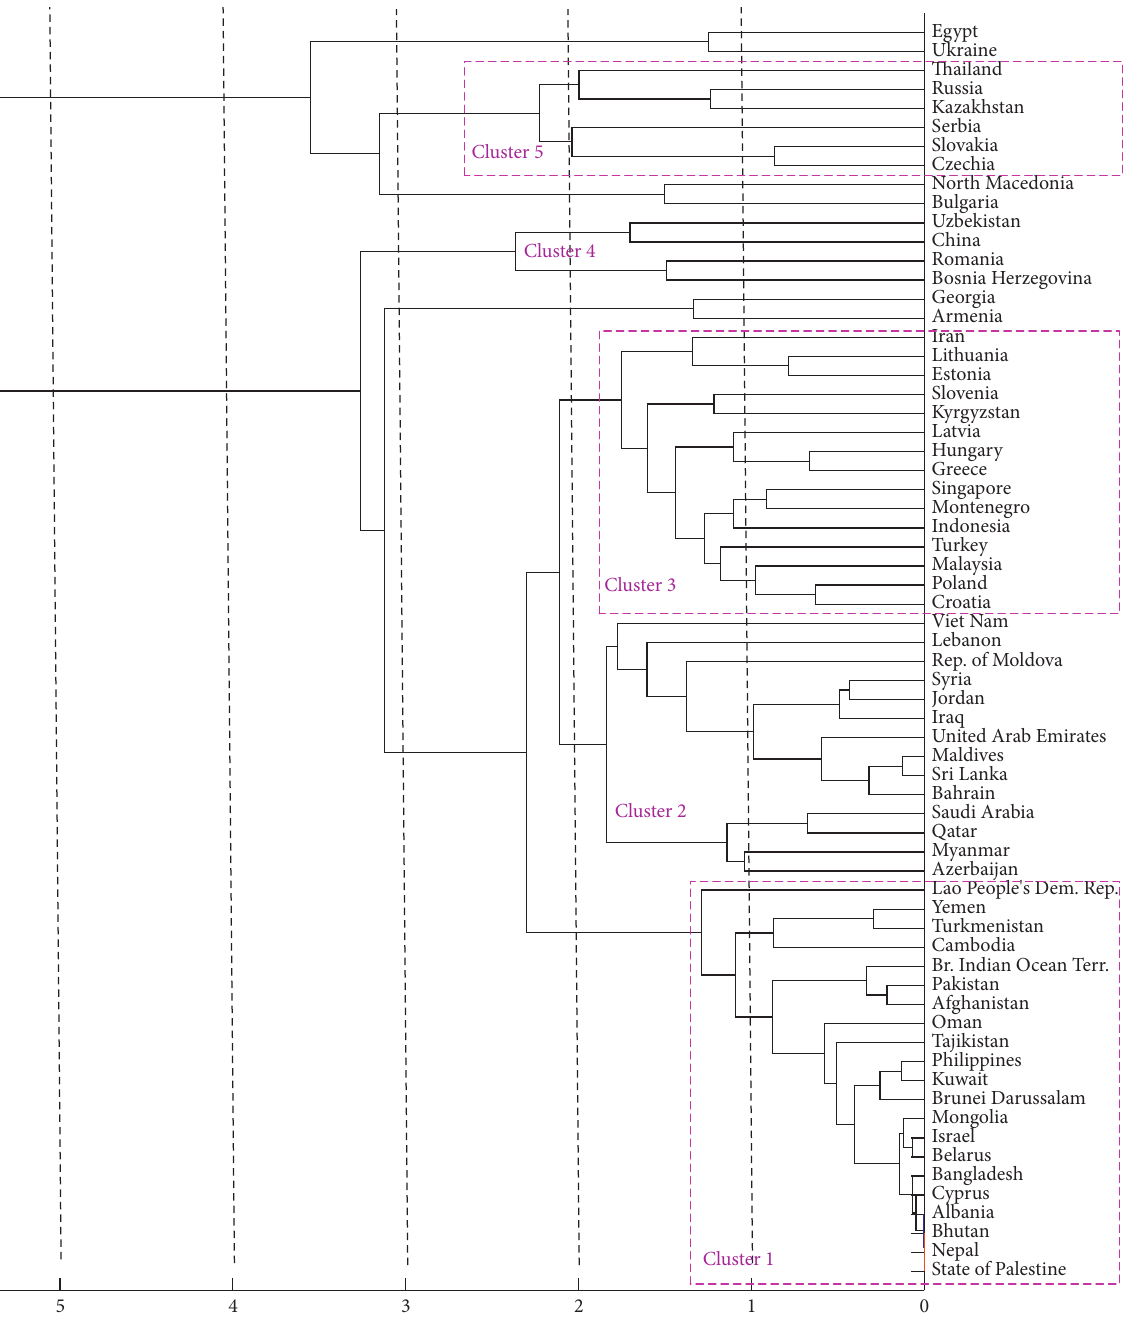
Figure 9: Dendrogram of cluster